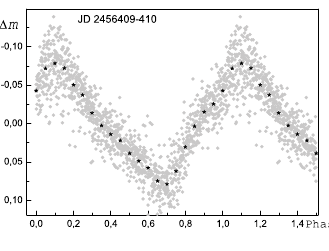
Figure 7: Ordinary superhumps on days 7-8 AM.